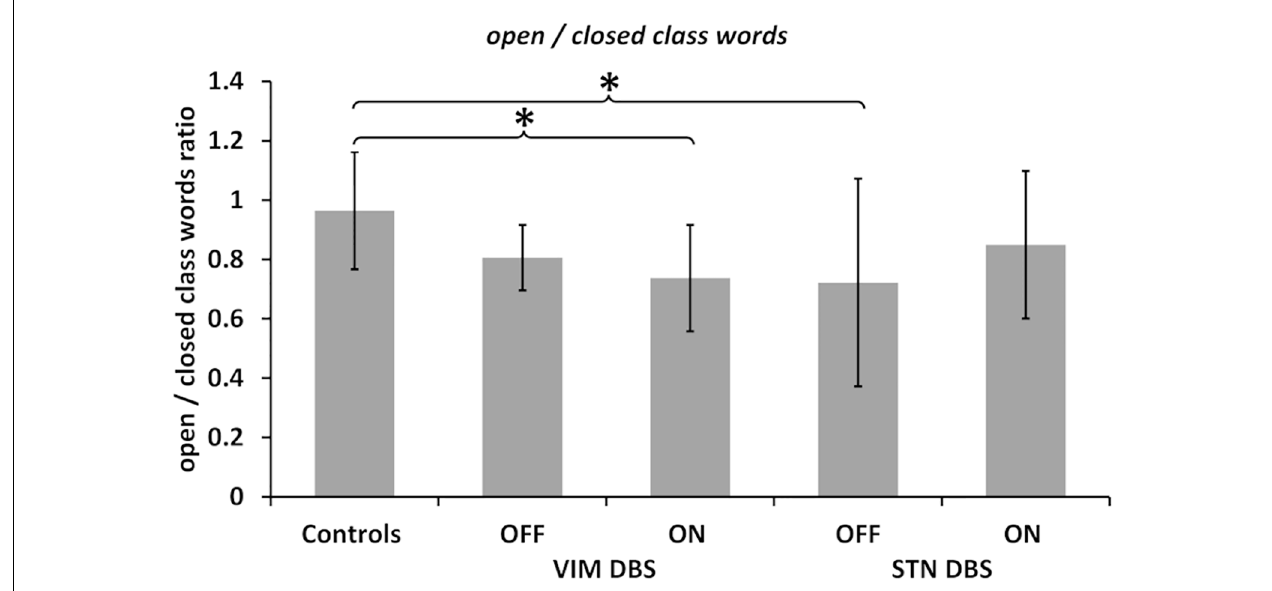
FIGURE 1 | Open/closed words ratio. Ratios calculated between the number of open class words divided by the number of closed class words in all groups and deep brain stimulation (DBS) ON and OFF conditions as noted. Values are group averages with error bars indicating standard deviations. Significant ( p < 0.05) comparisons between Controls and the DBS groups or between stimulation conditions are marked with